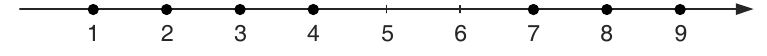
Figure 3. A 1-dimensional test dataset. Each point represents a 1-dimensional